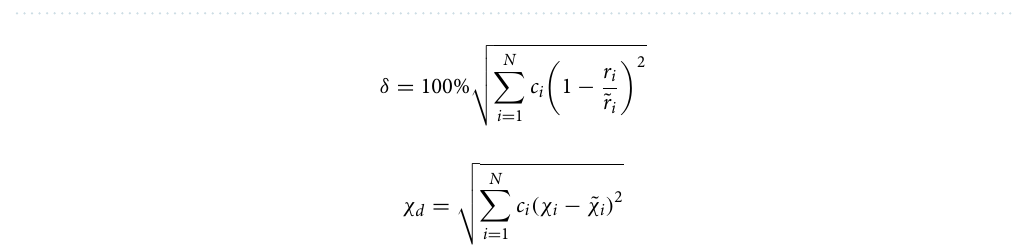
Figure 6. Details of the feature transformation process in this work. Through the ensemble regression tree and average pooling, raw features in the N -element alloy are transformed into expandable features. With { σ δ } features, σ ex d can be obtained in the same